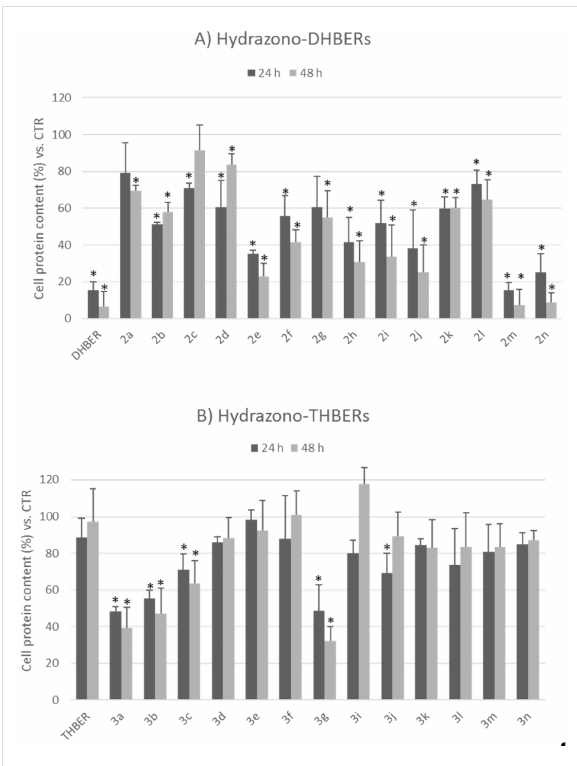
Figure 6: Effects of 25 µM hydrazono-DHBERs 2a–n and hydrazono- THBERs 3a–g,i–n [70] on NCI-H1975 cell proliferation as evaluated by SRB assay (estimating total protein content) at 24 h and 48 h of treat- ment. Data are expressed as mean ± SD ( n = 3). * p < 0.05 vs CTR (DMSO